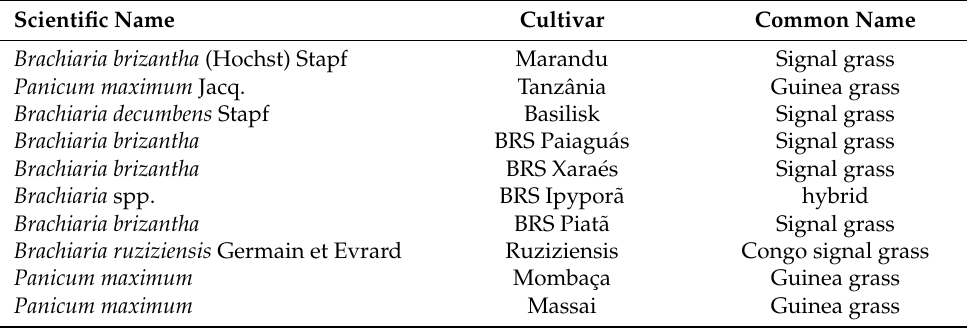
Table 1. List of grass forage species of the Poaceae family here